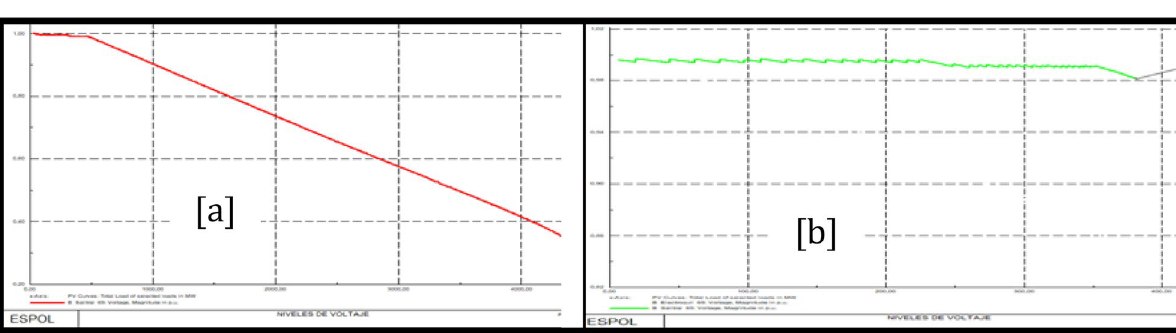
Figure 15. Stability PV before load model ( a ) and PV after load model ( b ) Salitral 69 kV bus.